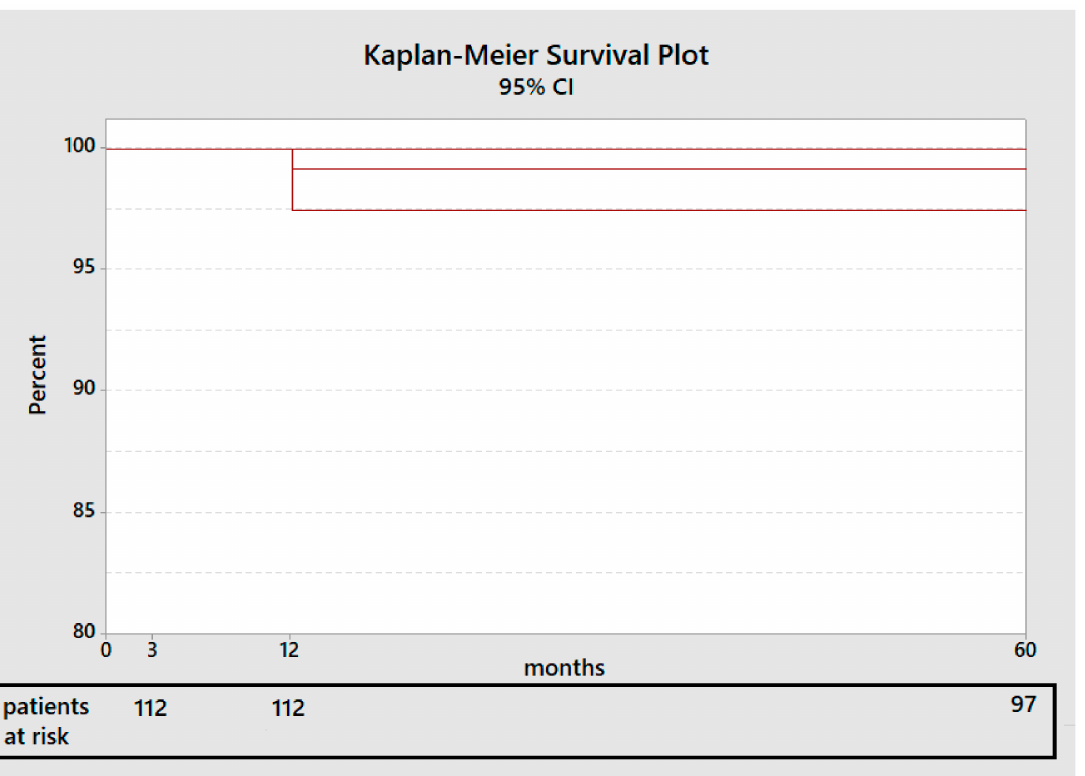
Figure 2. Stem survival rate (Kaplan-Meier curve. The red line represents the stem survival rate at 5